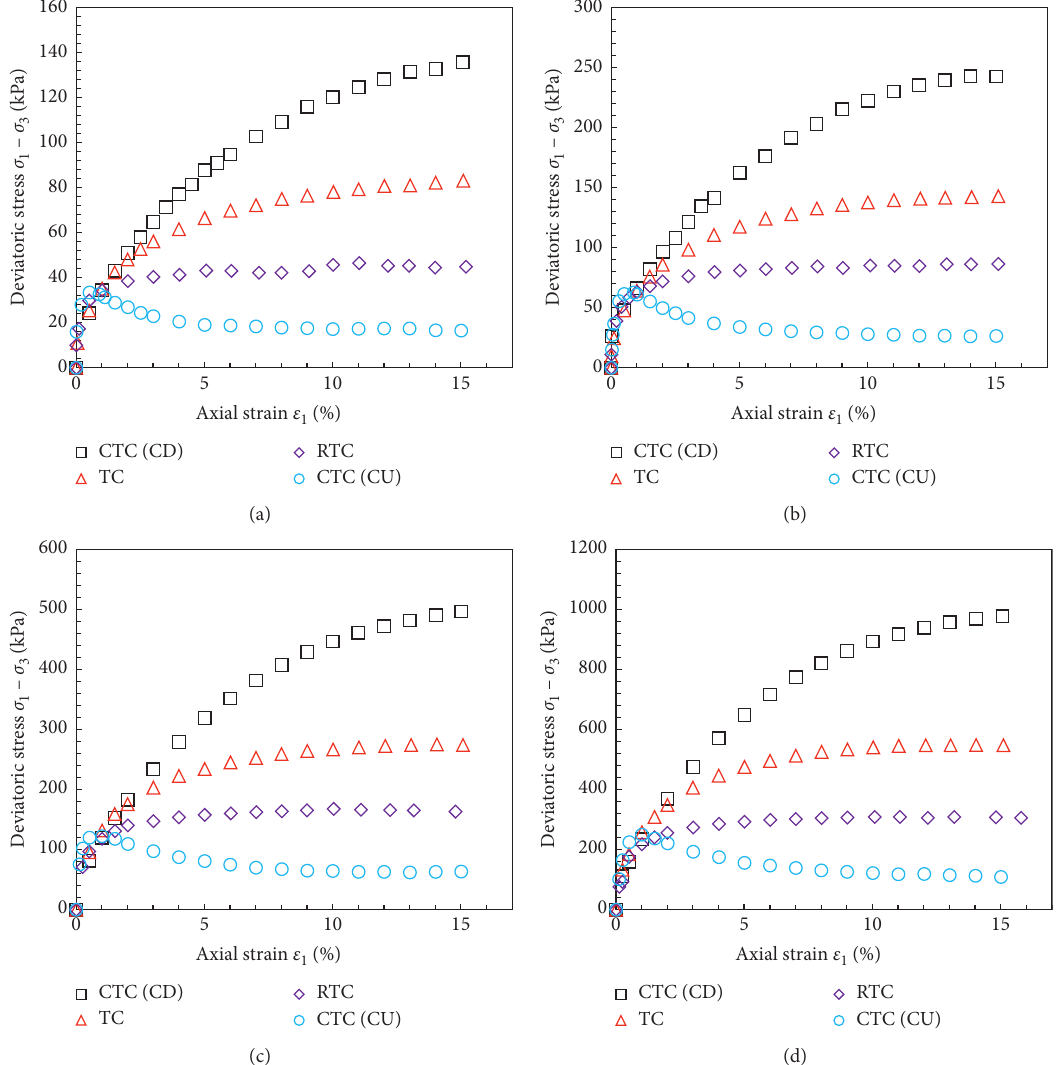
Figure 4: Deviatoric stress-axial strain curves of gravelly sand under different stress paths: deviatoric stress-axial strain curves (a) σ 3 � 50 kPa; (b) σ 3 � 100kPa; (c) σ 3 � 200kPa; (d) σ 3 �